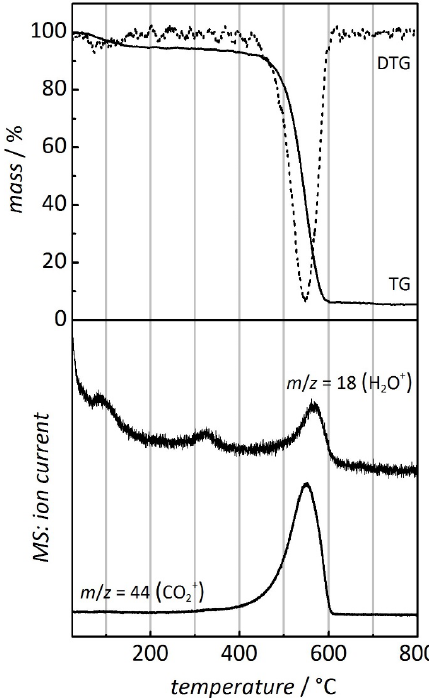
Figure 1. Thermogravimetric/derivative thermogravimetric (TG/DTG, ( top )) and mass ion detection (MS, ( bottom )) analysis of ordered mesoporous CMK-3 carbon. Heating rate: 10 °C min − 1 ; atmosphere: O 2 /Ar, 20:80